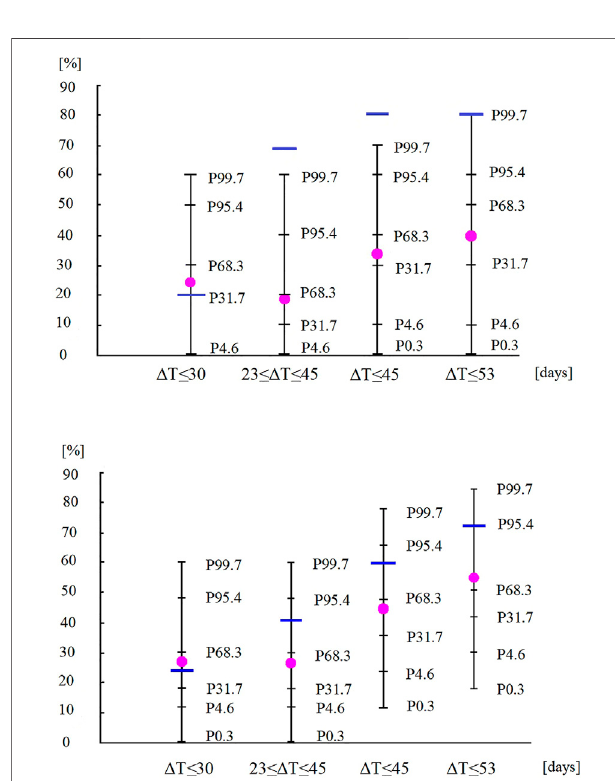
FIGURE 4 | AAR (top) in the randomly generated catalogue and EOR (bottom) in the randomly generated cloud anomalies. Magenta points denote themeanvalueofthesimulateddata;shorthorizontalbarsindicatepercentiles of simulated data and blue bars indicate the actual value of real data. Clearly the actual values of AAR and EOR are higher than those expected by chance except Δ T ≤ 30 days.